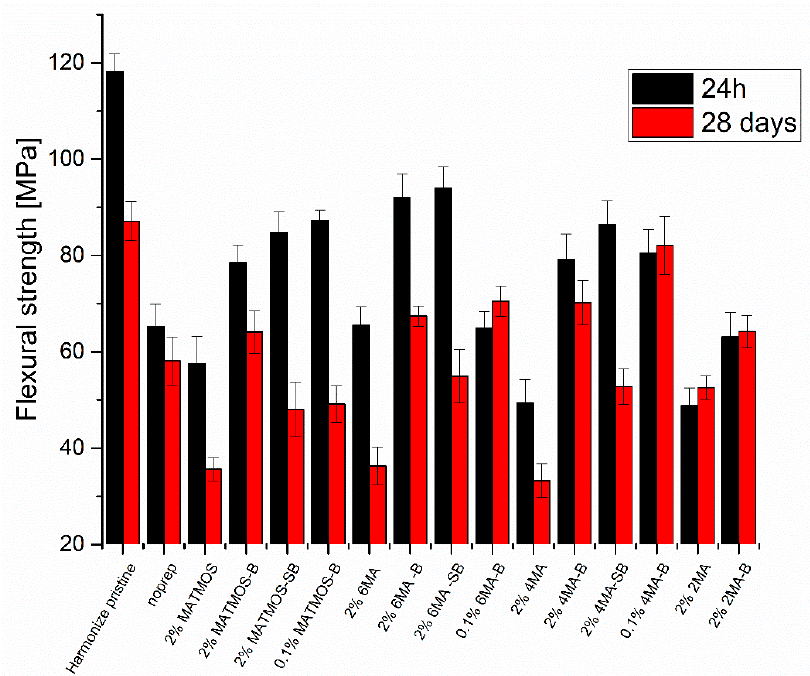
Figure 6. Flexural strength of composite materials before and after priming and repair.